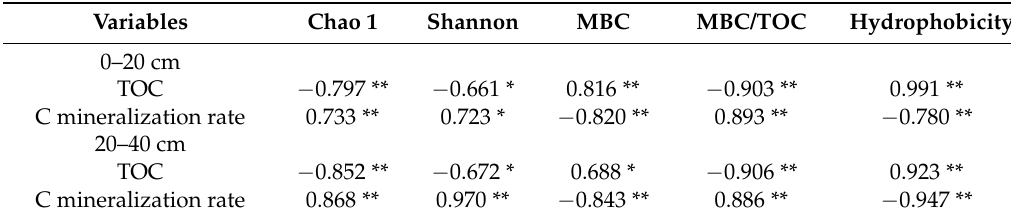
Table 5. Pearson’s correlation for testing the association among bacterial diversity indices, soil hydrophobicity, and C mineralization rate.